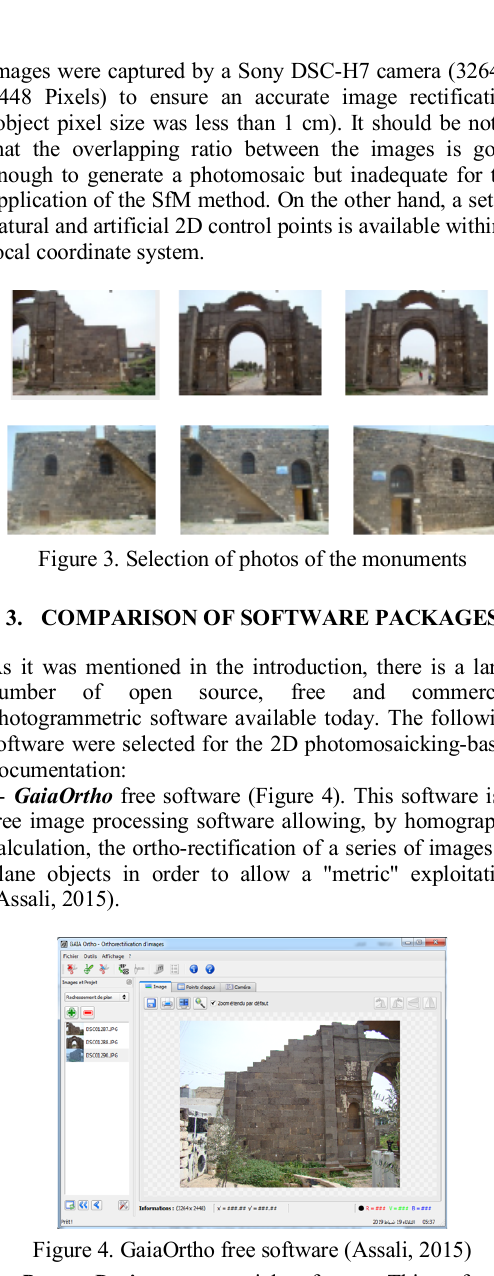
Figure 1. Western gate, city of Bosra al-Sham (Syria)